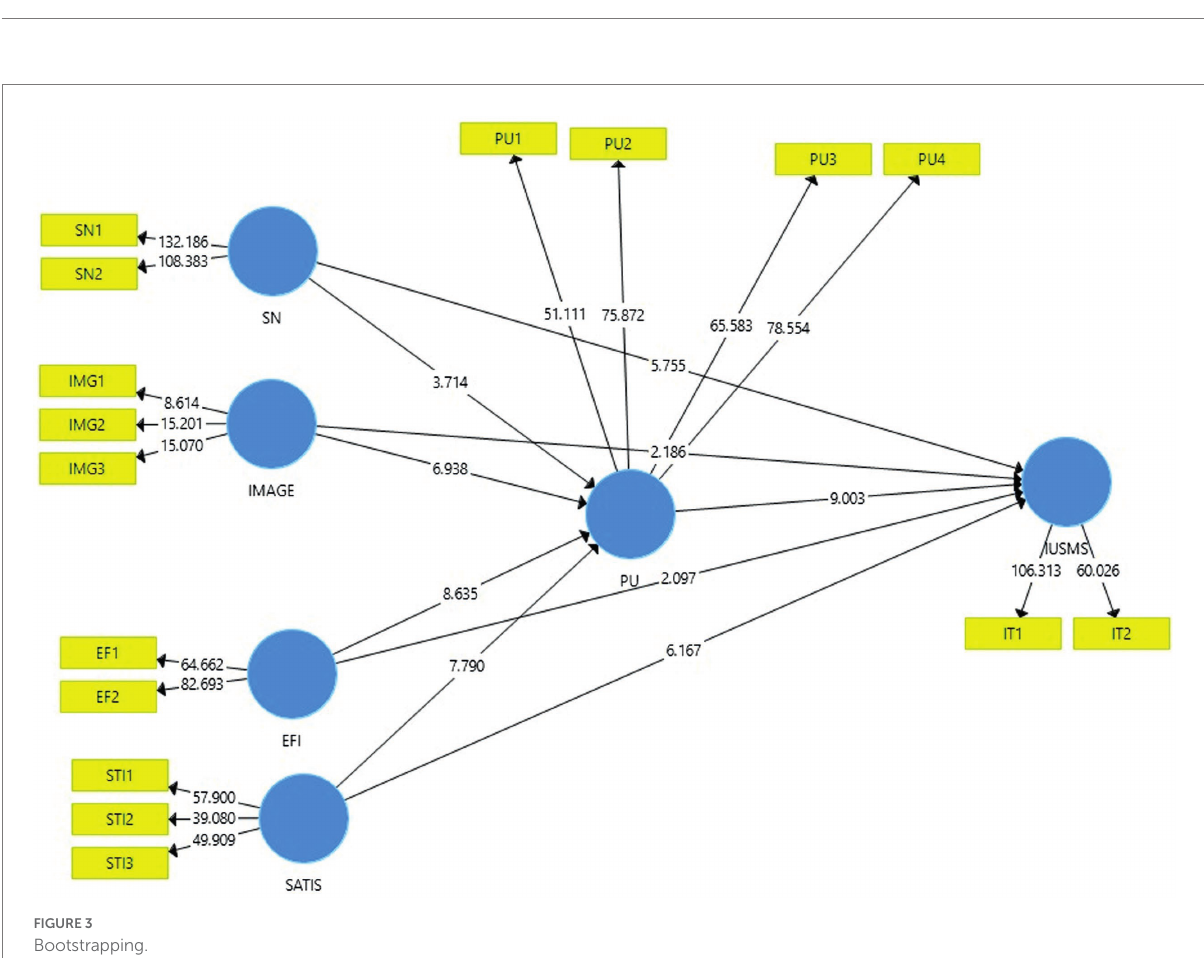
FIGURE 3 Bootstrapping.